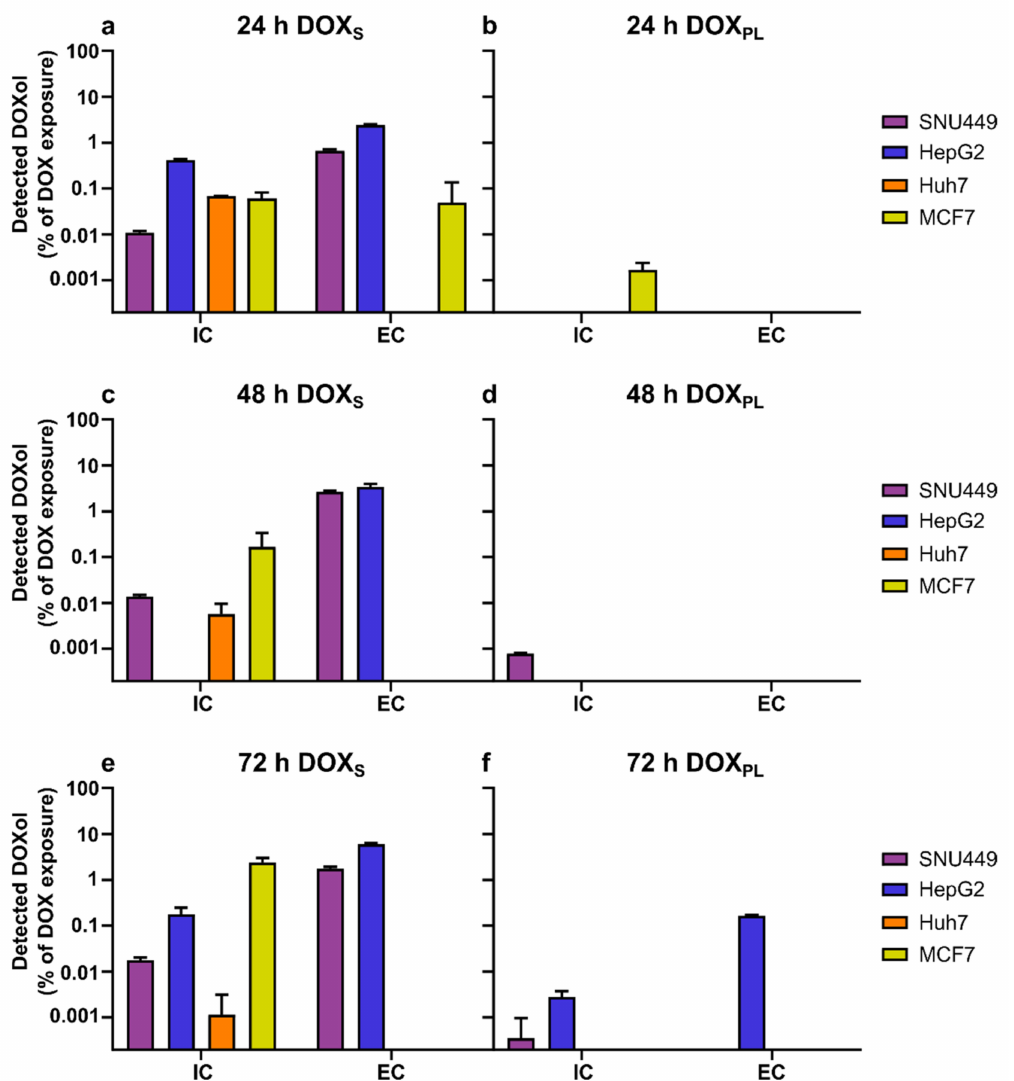
Figure 4. The mean ( ± SD) amount of DOXol quantified inside (intracellular, IC) and outside (extracellular, EC) the cells, as a percentage of total added dose of DOX. ( a , c , e ) Cells treated with DOX S ; ( b , d , f ) cells treated with DOX PL . The exposure concentration was based on the calculated IC 50 of that treatment determined in this study, with a maximum concentration of 200 µ